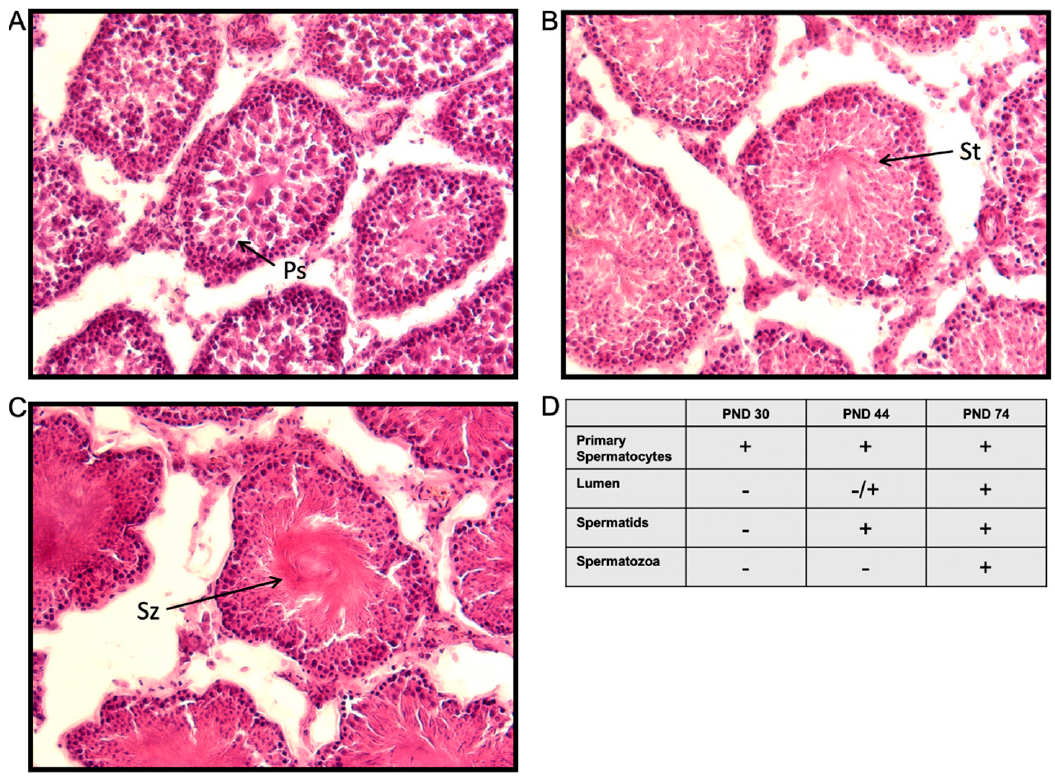
Figure 2. Representative images of testes morphology across male pubertal development. Histological cross-sections of testes stained with hematoxylin and eosin at ( A ) PND 30, ( B ) PND 44, and ( C ) PND 74 (N = 3/ age group). Arrows point to primary (Ps) spermatocytes, spermatids (St) and spermatozoa (Sz). ( D ) Table summarizing morphological differences in testes between PND 30, PND 44, and PND 74. Morphological markers are indicated as present (+) or absent ( − ) in 100% of animals within an age group. Morphological markers present in less than 100% of animals within an age group indicated as ( − /+).